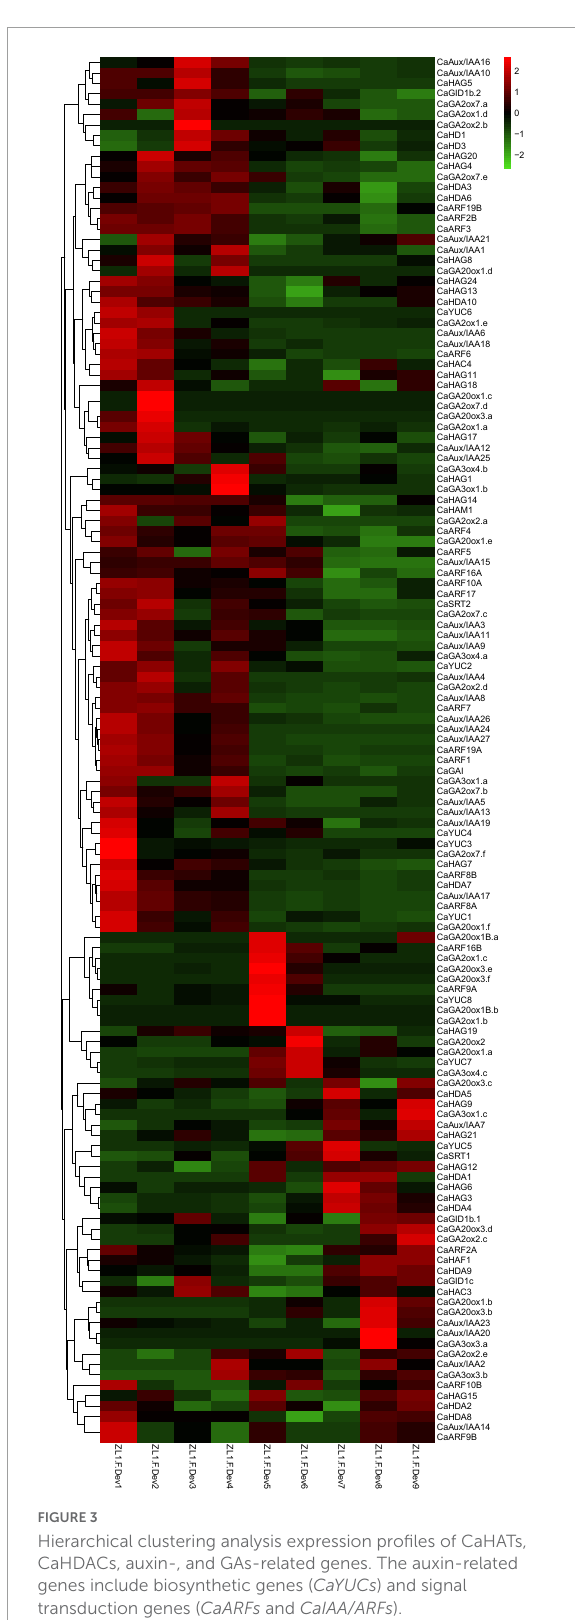
FIGURE3 Hierarchical clustering analysis expression profiles of CaHATs, CaHDACs, auxin-, and GAs-related genes. The auxin-related genes include biosynthetic genes ( CaYUCs ) and signal transduction genes ( CaARFs and CaIAA/ARFs